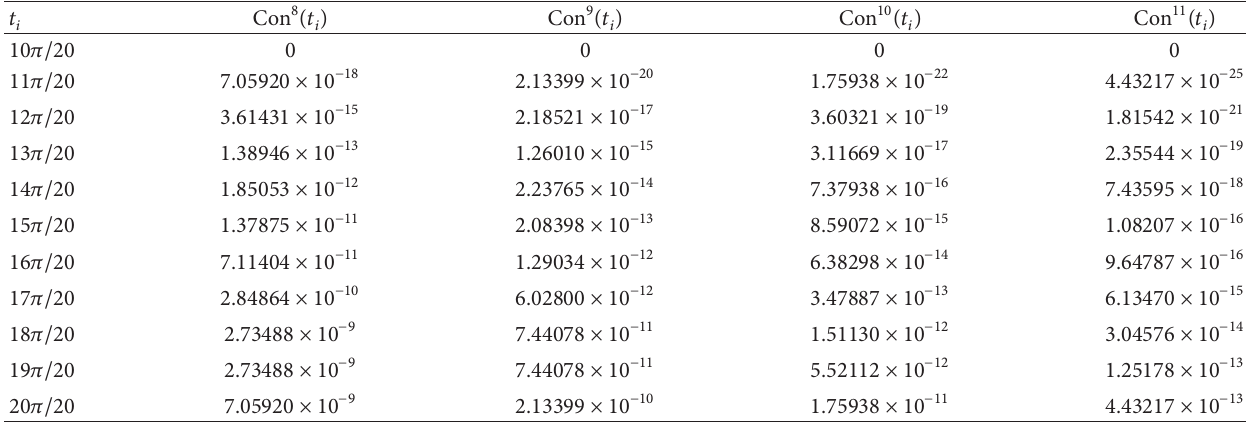
Table 3: The values of consecutive error function at 𝑘 = 8,9, 10, 11 for different values of 𝑡